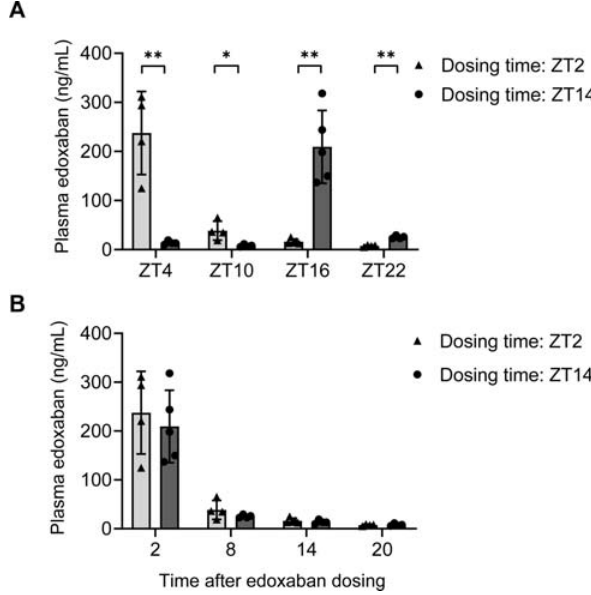
Fig. 4 Effect of dosing time on the pharmacokinetics of edoxaban. Rats were administered edoxaban (10mg/kg) at zeitgeber time (ZT)-2 (light gray bars) or ZT14 (dark gray bars). Blood samples were obtained at 2, 8, 14, and 20hours after dosing. The plasma edoxaban concentrations ( A ) at each ZT and ( B ) at the indicated times after dosing. Data represent the means (cid:3) standard deviation ( n ¼ 4 – 5). (cid:4) p < 0.05, (cid:4)(cid:4) p < 0.01 versus edoxaban dosing of the ZT2 group at the same ZT.